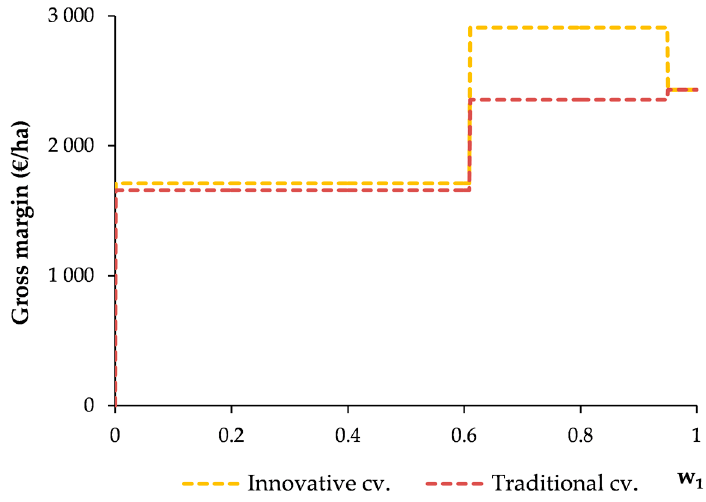
Figure 6. Trend of gross margins following the introduction of innovative cultivars.